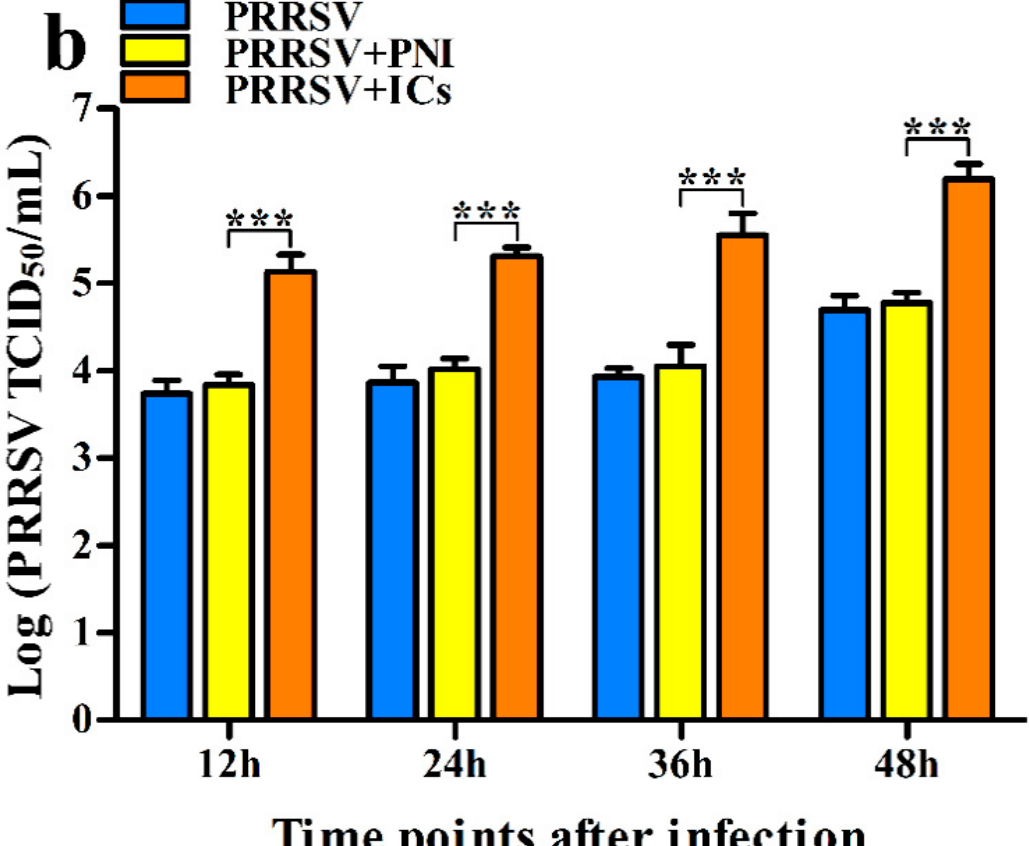
Figure 1. Effect of pig anti-PRRSV specific IgG on the replication of PRRSV in PAMs. PAMs cells were infected with PRRSV + ICs, PRRSV + PNI, or PRRSV. The RNA levels ( a ) and the virus titers ( b ) of PRRSV in cell supernatants harvested were evaluated by real-time RT-PCR and TCID 50 assay. *** p < 0.001.